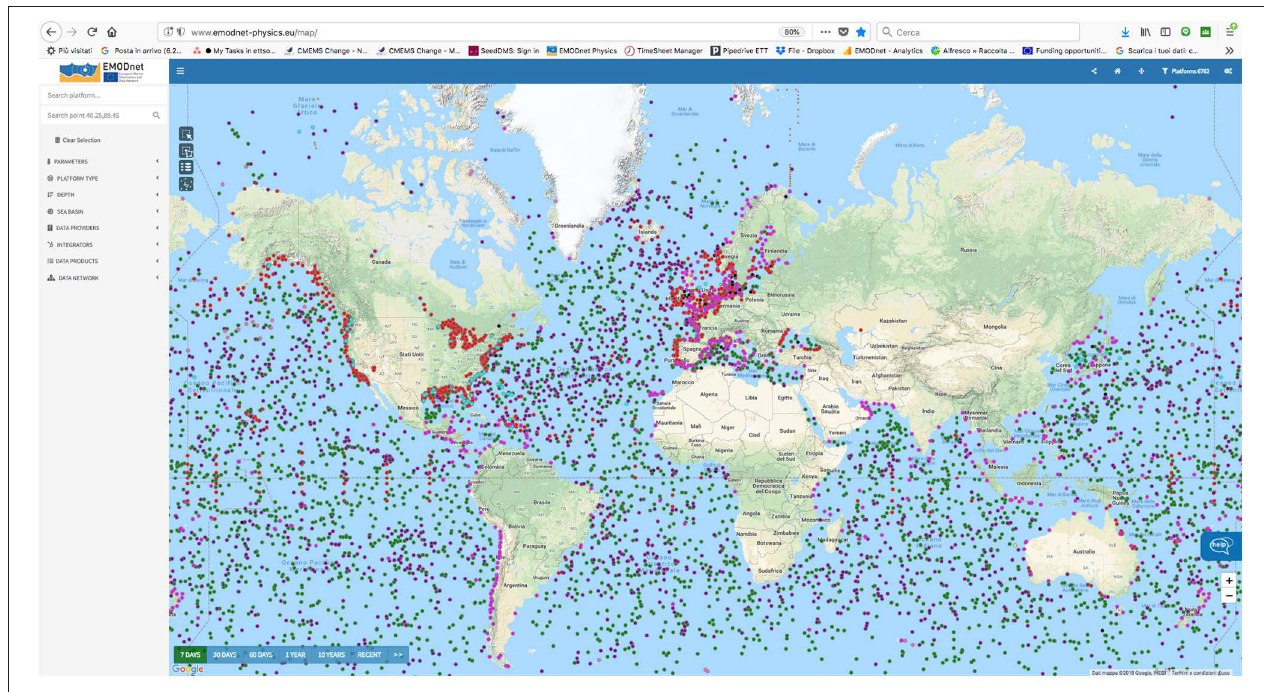
FIGURE 2 | 1Example of data accessible in EMODnet Physics during a 1 week